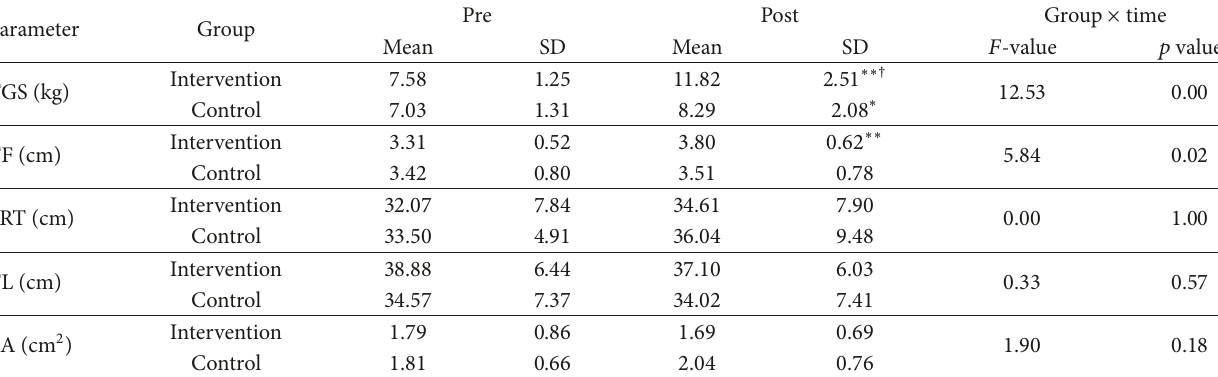
Table 2: Comparison of parameters before and after training between the intervention ( 𝑛 = 14 ) and control groups ( 𝑛 = 14 ). Parameter Group